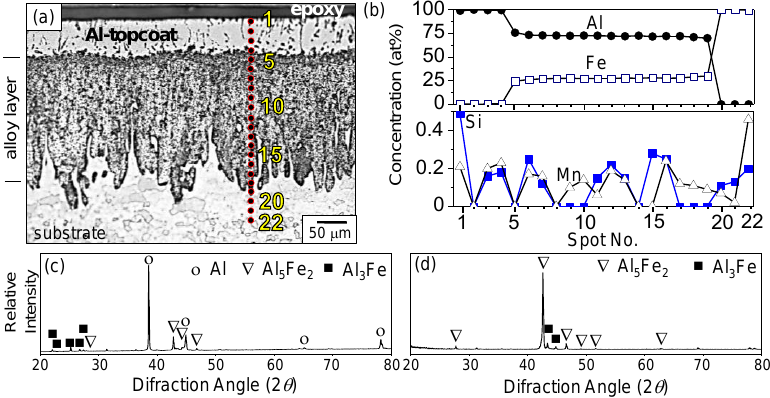
Figure 1. Al hot-dipped carbon steel: ( a ) Etched cross-sectional OM image; ( b ) EDS concentration profiles along the spots 1–22 marked in Figure 1a; ( c ) XRD pattern taken from the air-side; ( d ) XRD pattern after grinding off the Al